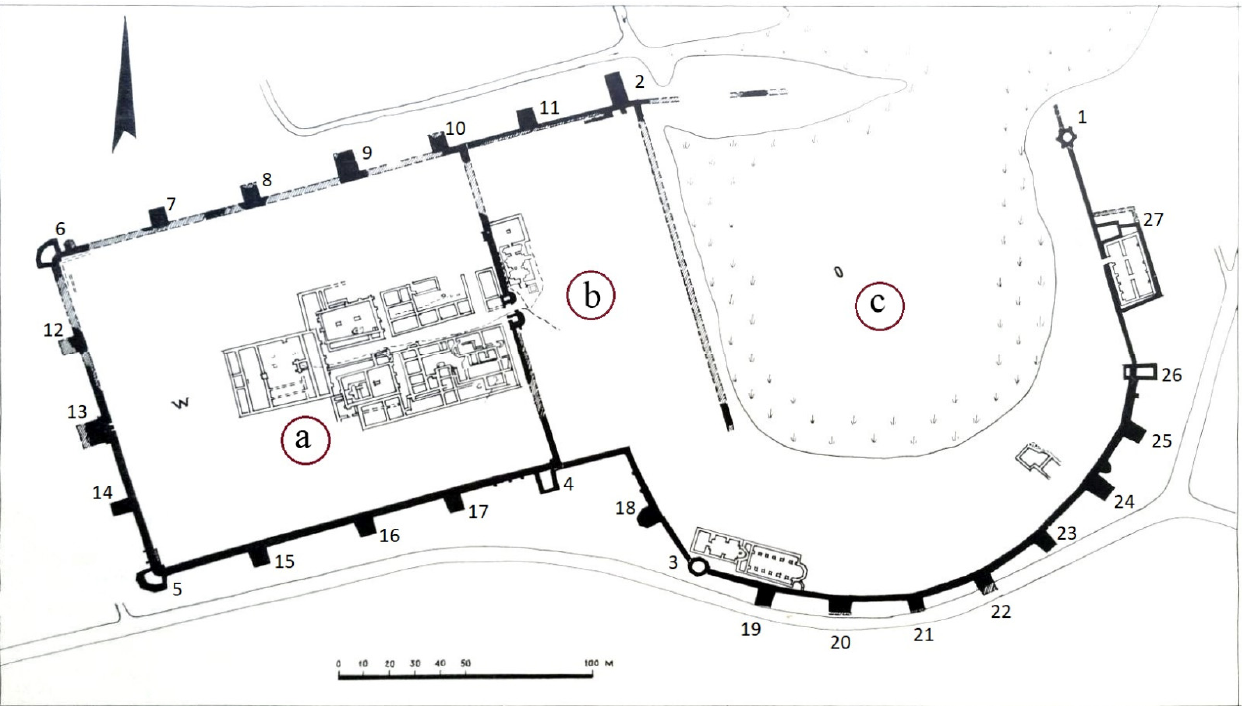
Figure 3. General plan of Pitiunta fortress, adapted from ref. [26]: a—castellum (end of II–beginning of III centuries AD); b—expansion of the castellum to the east (middle of the 3rd century AD); c—canaba (late III–mid IV centuries AD).